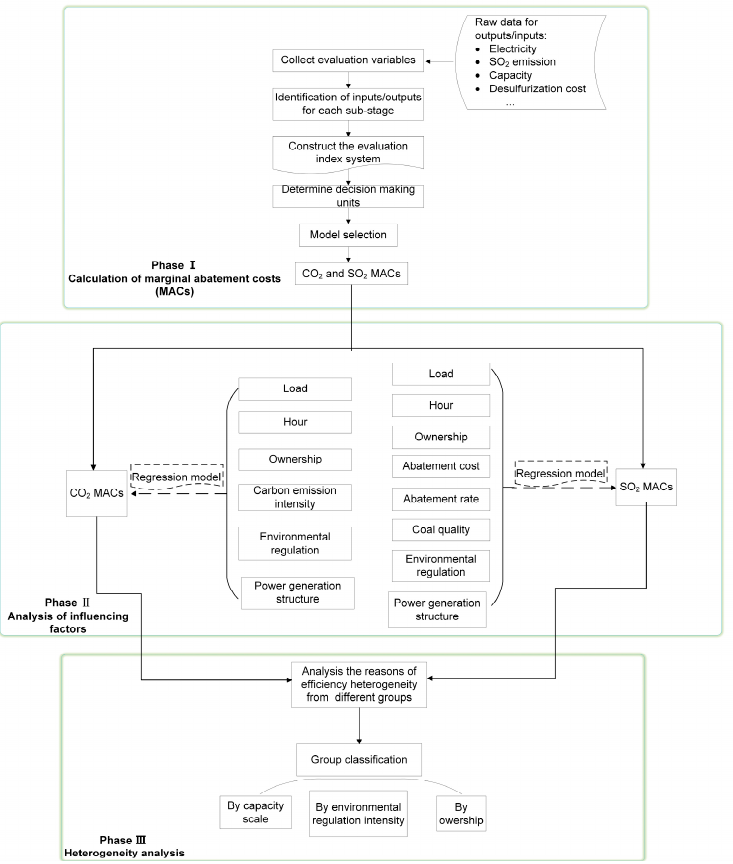
Figure 1. Research framework of this study.